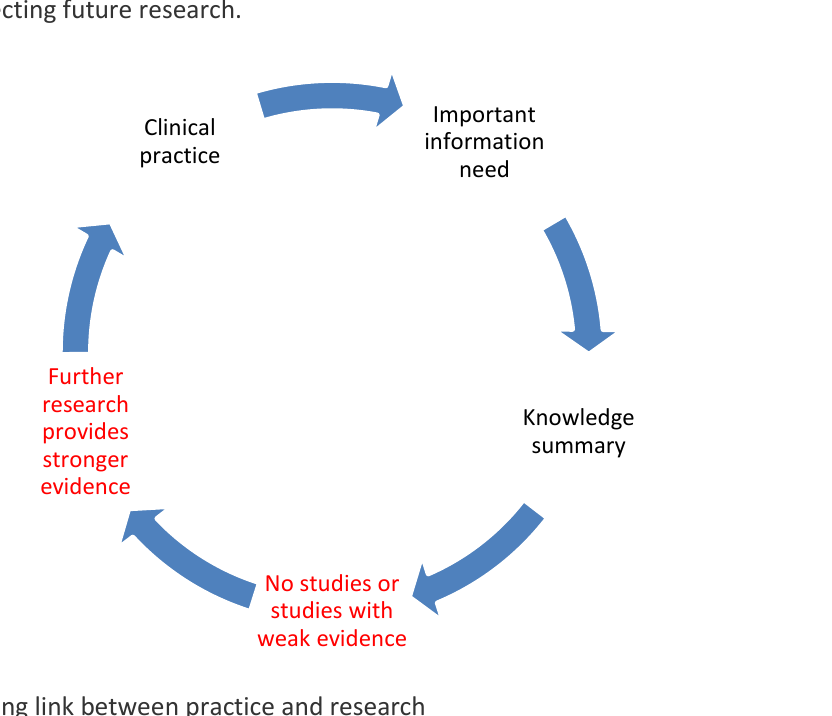
Figure 1: The missing link between practice and